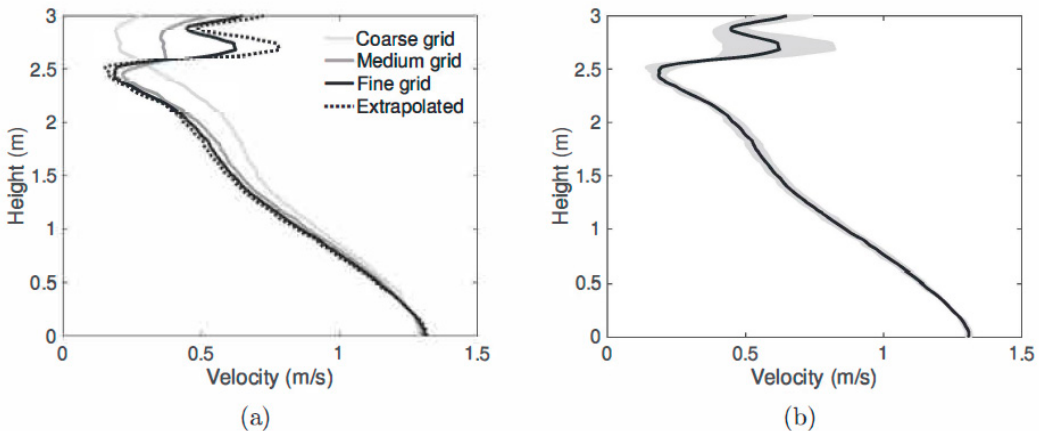
Figure 3. Velocity profiles along L5 for ( a ) all the different grids and ( b ) the fine grid with error bands.